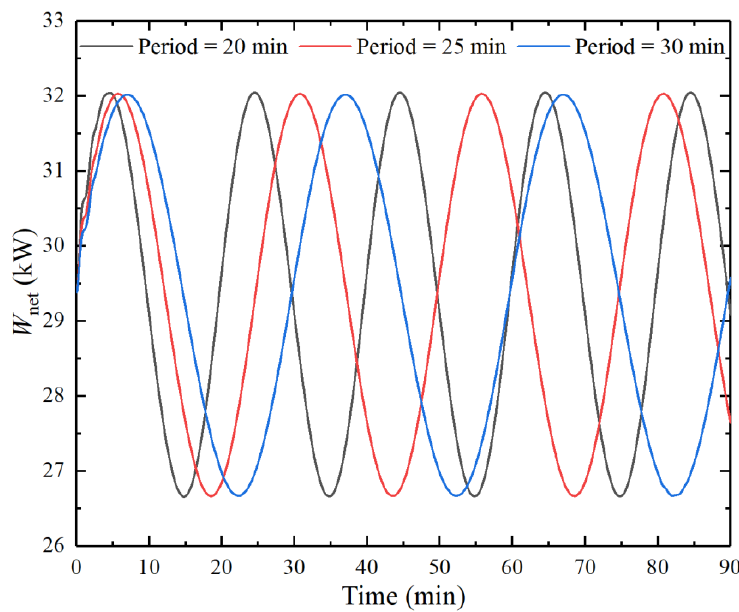
Figure 13. Net power output under different periods.